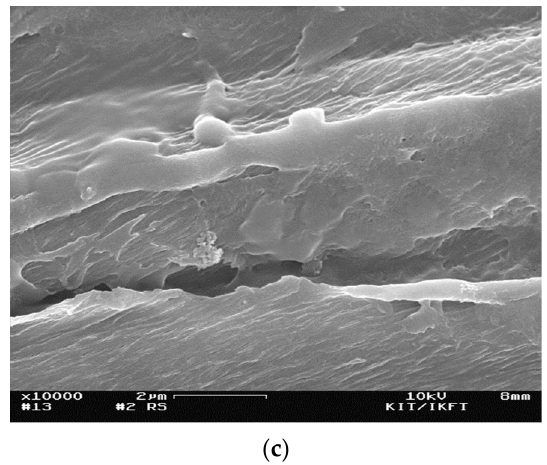
Figure 5. SEM images of ( a ) untreated rice straw and steam-exploded residue at a severity parameter of ( b ) S 0 = 4.10 min and ( c ) S 0 = 5.29 min.